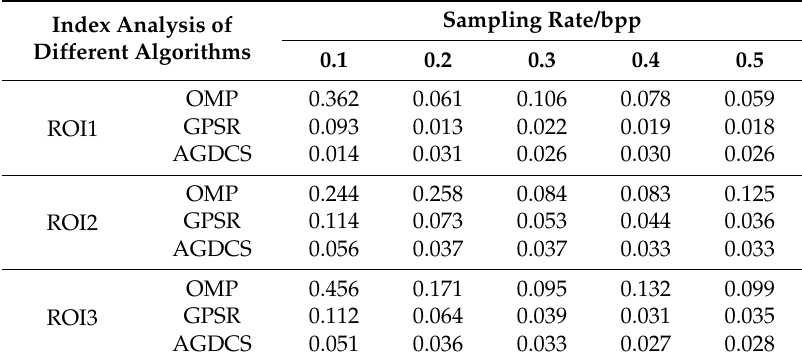
Table 6. RMSE comparison of spectral indices of Area550–750.